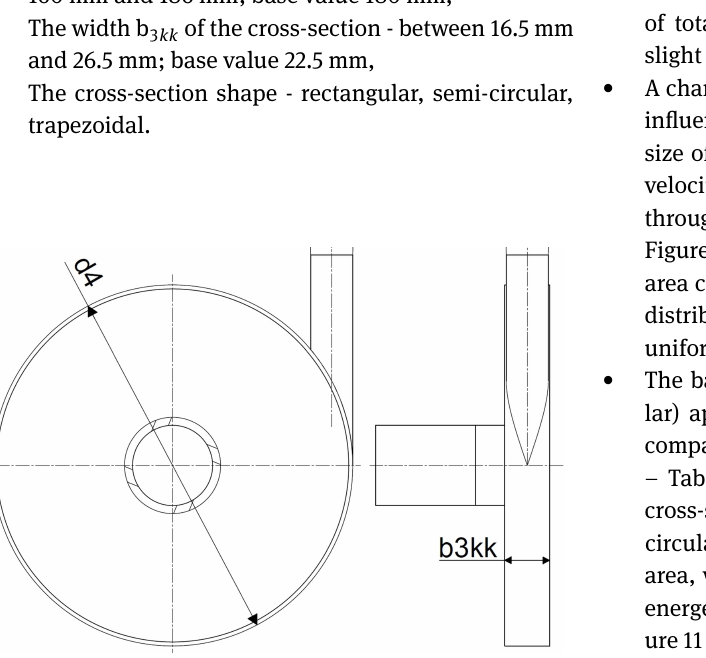
The results of the calculations can be found in Fig- ure 10. Table 3, on the other hand, shows the results ob- tained after a change of the cross-section shape of a chan- nel’s profile. The tests were performed for a constant flow rate, corresponding BEP (Q = 5.1 m 3 /h). A variant of